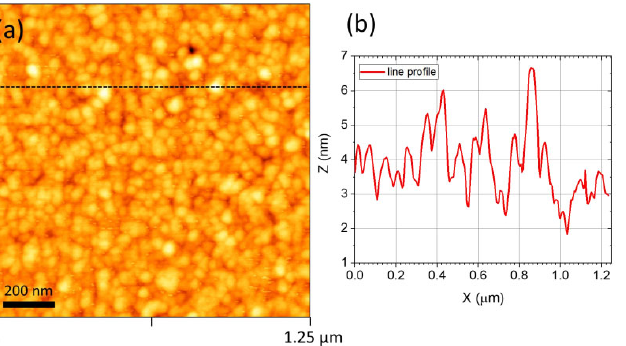
Figure 4. ( a ) AFM image of surface morphology and ( b ) line scan (across the dashed line) of the laser ‐ ablated gold nanoparticle ‐ coated U ‐ bent optical fiber.